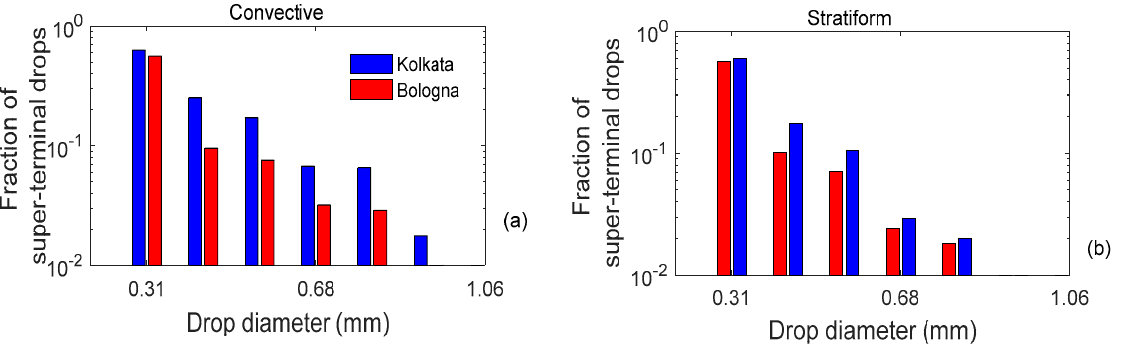
Figure 5. Fraction of super-terminal drops for ( a ) convective and ( b ) stratiform rain in Kolkata and Bologna. The fraction of super-terminal drops represents the ratio of these drops and the total number of drops.